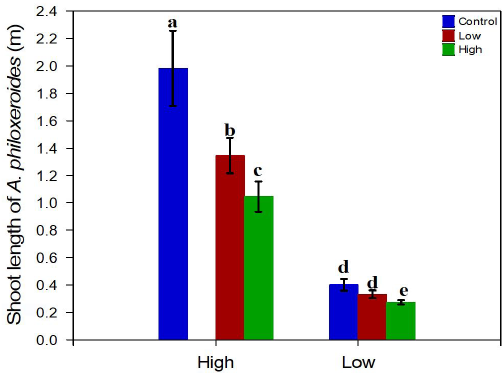
Figure 2. Shoot length of Alternanthera philoxeroides according to the density of neighbor specie (H density or L density), the nutrient level (H nutrient or L nutrient) and treatment control.